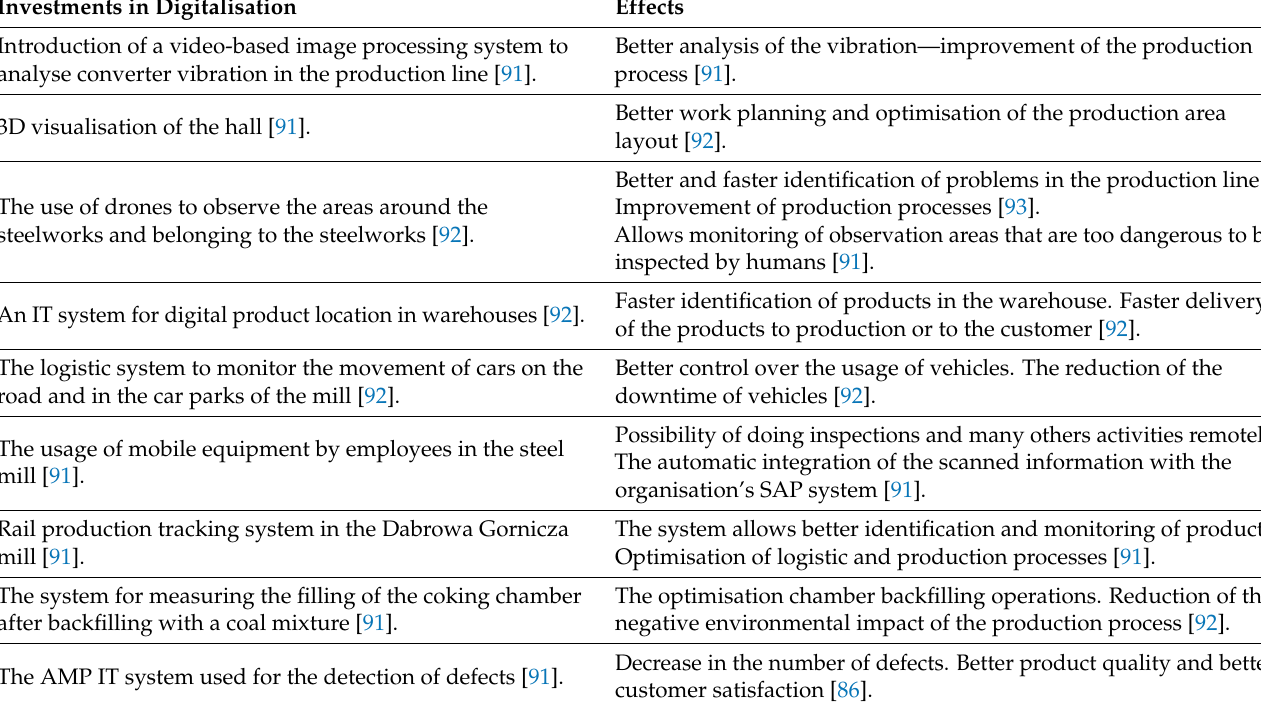
Table 3. Investments in digitalisation in ArcelorMittal Poland and its effects. Investments in